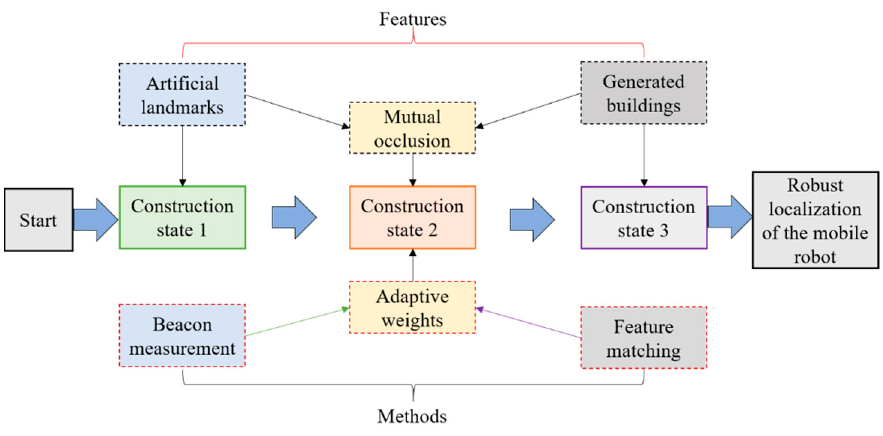
Figure 3. Localization diagram of mobile robot in the ongoing scene.